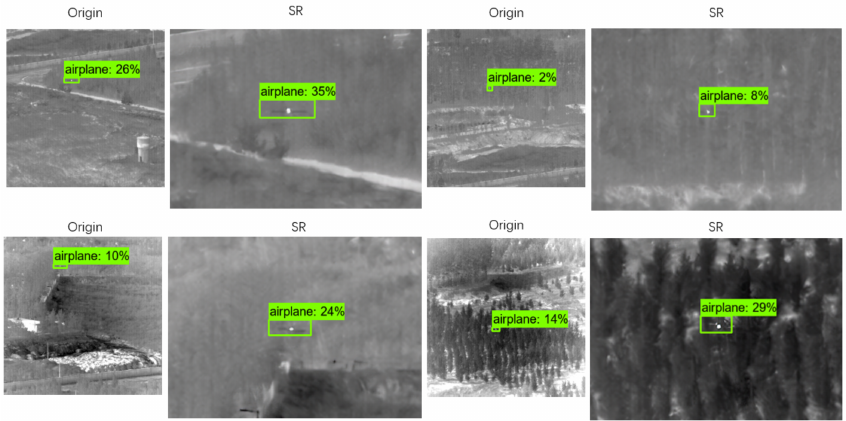
Figure 10. Example of confidence degree of the partial original image and reconstructed image in target recognition network